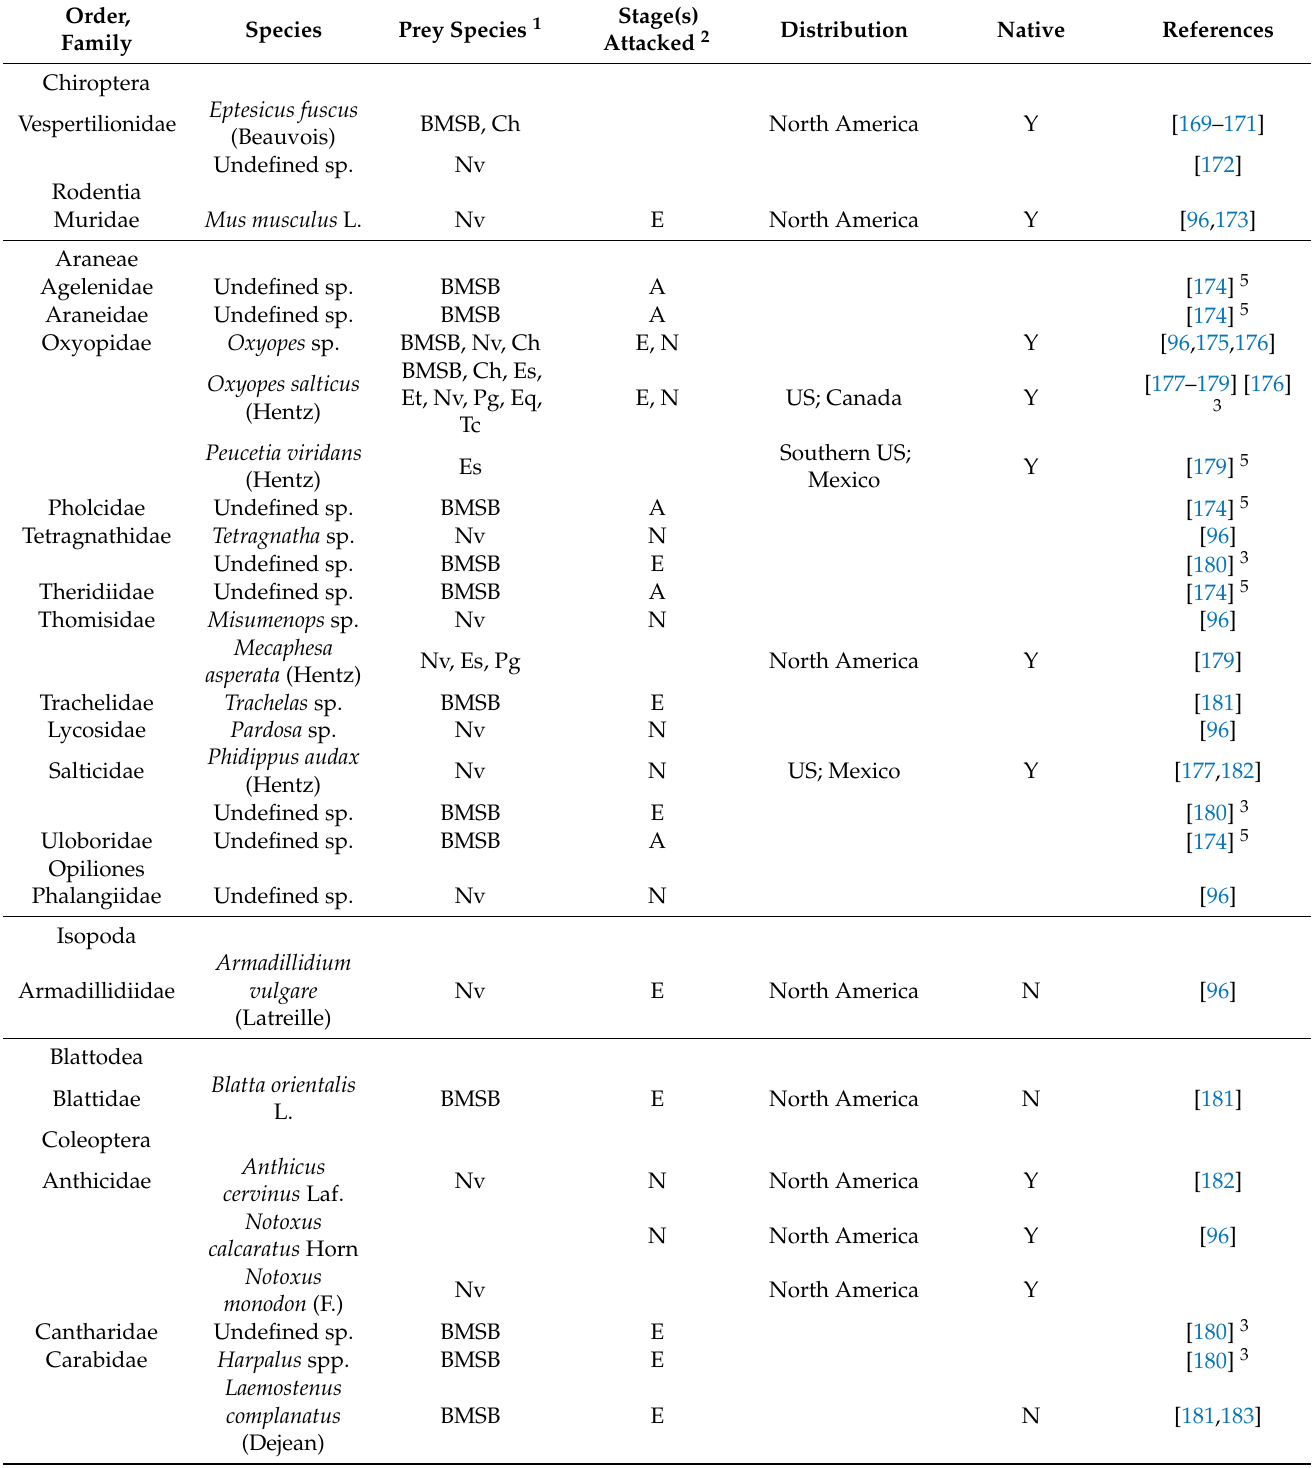
Table 2. Predators of stink bugs reported in North America, with hosts, stages attacked, and coarse